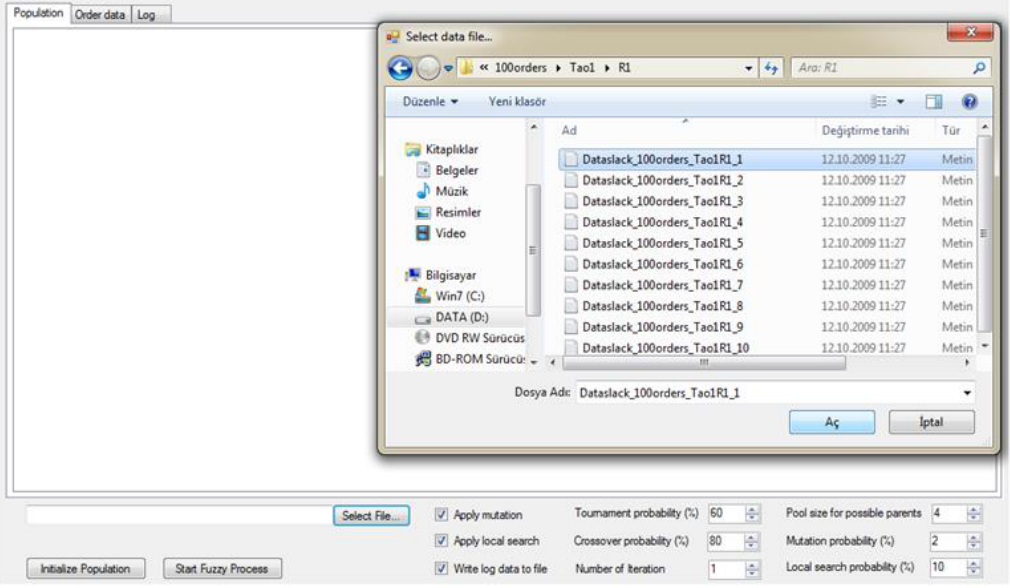
Figure A2. Transfer of the data to the